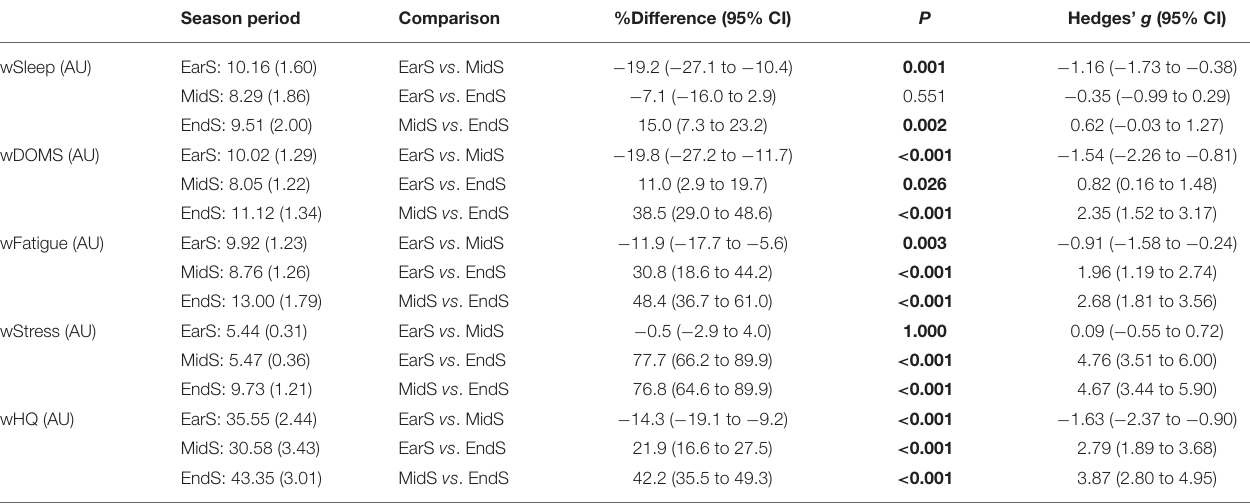
TABLE 2 | Comparison between season periods, considering well-being variables. Season period